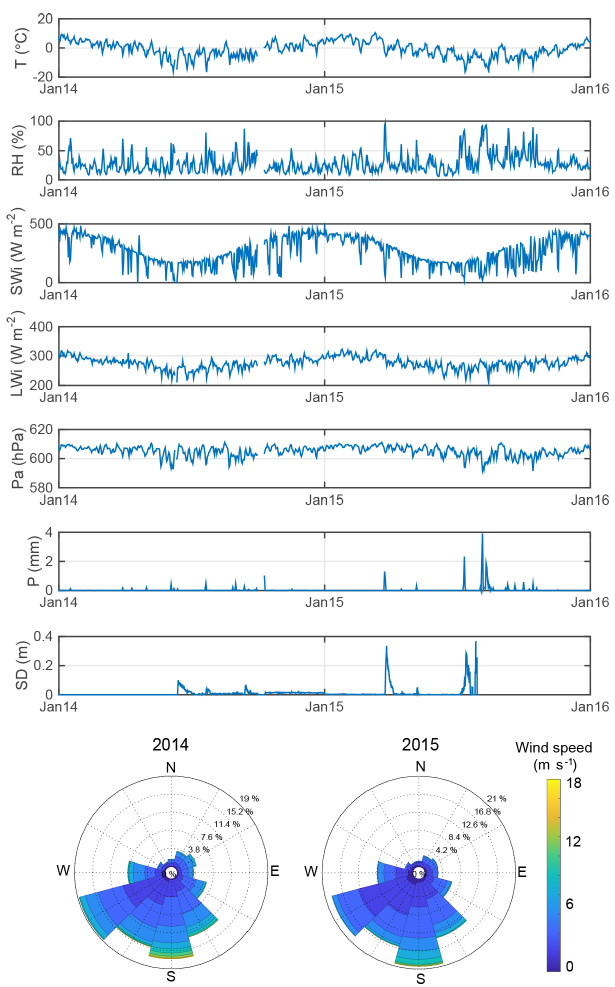
Figure 3. Example of meteorological conditions of the study area. Daily air temperature ( T ), relative humidity (RH), incoming short- wave (SWi) and longwave (LWi) radiation, air pressure (Pa), precip- itation ( P ), snow depth (SD), and hourly wind speed and direction (wind roses) measured at the Tapado AWS from 1 January 2014 to 31 December 2015. Note that SD measurements are available until 1 August